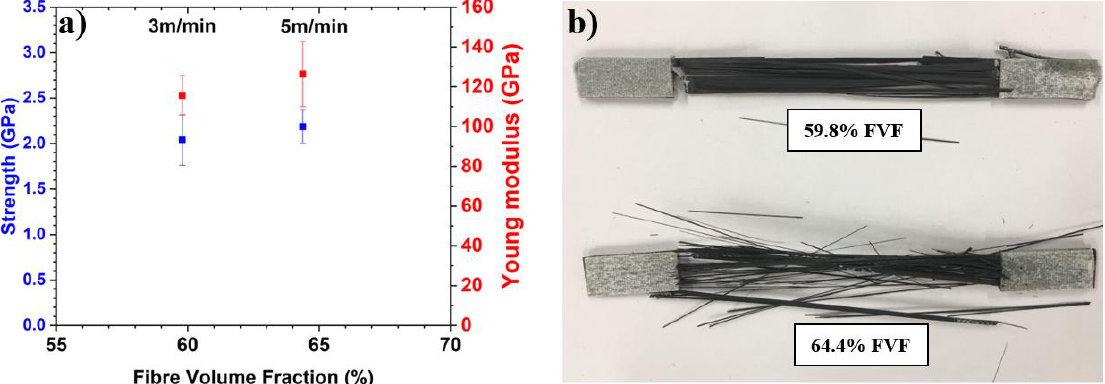
Figure 9. ( a ) Tensile test results of the UD-CFRP plates. ( b ) Different splitting modes of samples.